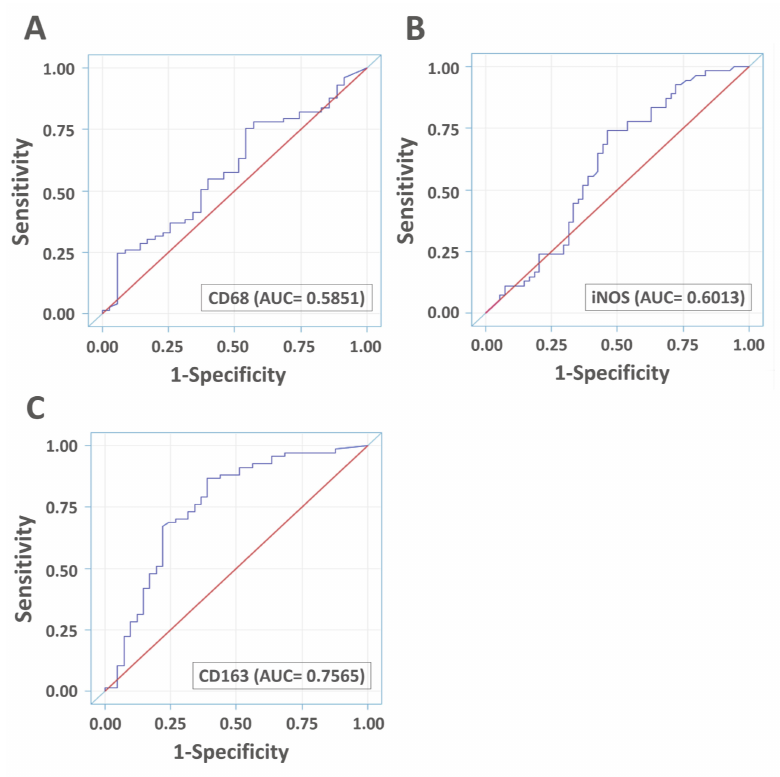
Figure A2. Analysis for the diagnostic accuracy of using TAMs expression in gliomas by ROC curve. ROC analyses for the diagnostic accuracy of using CD68 ( A ), iNOS ( B ), and CD163 ( C ) expression were calculated. The AUC estimates evaluated by this approach are reported under the ROC association statistics section of data